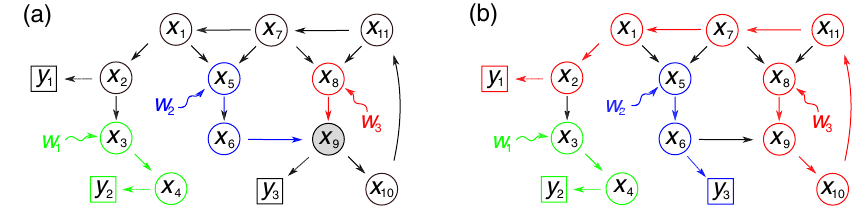
FIG. 3. The graphical condition for invertibility. (a) The system represented by the influence graph with input node set S ¼ f x 3 ; x 5 ; x 8 g is noninvertible if the output measurements y ¼ ð y 1 ; y 2 ; y 3 Þ (squares) are placed at the sensor node set Z ¼ f x 2 ; x 4 ; x 9 g . The only possible paths from the input nodes x 5 and x 8 to any of the outputs (here y 3 ) collide at x 9 . (b) The same graph with the same input nodes S as in (a), but with outputs y ¼ ð y 1 ; y 2 ; y 3 Þ (squares) placed at Z ¼ f x 2 ; x 4 ; x 6 g [i.e., x 6 replaces the sensor node x 9 in (a)] is invertible. There is a family Π ¼ f w 1 ⇝ x 3 → x 4 → y 2 ; w 2 ⇝ x 5 → x 6 → y 3 ; w 3 ⇝ x 8 → x 9 → x 10 → x 11 → x 7 → x 1 → x 2 → y 1 g of three nonintersecting (node disjoint) paths joining each input with one